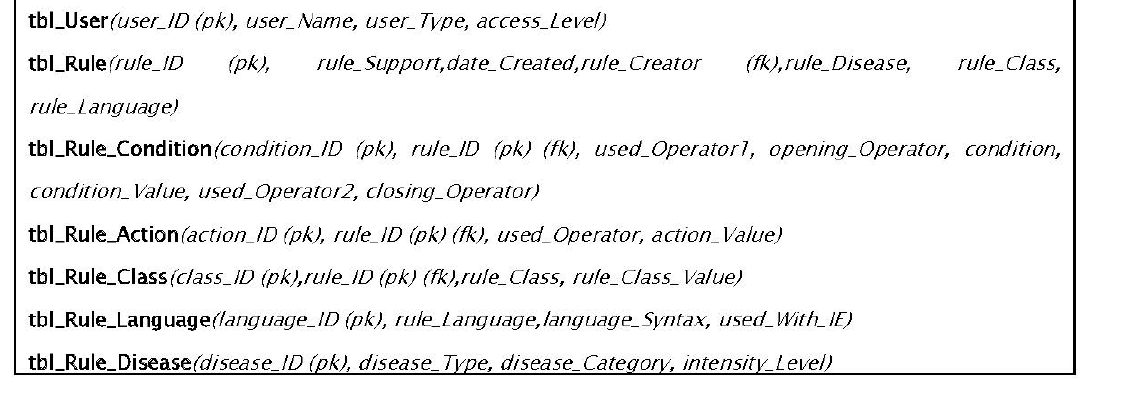
Figure 6. Generic storage structure for rules storage in Rule-base.